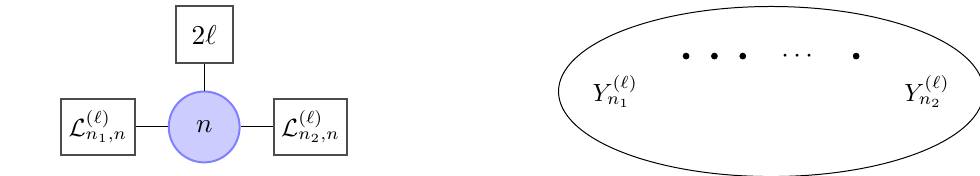
. The 1 ;n;n 2 is larger than 1 ;n;n 2 simple punctures ‘ and Y ( ‘ ) n . 1 2